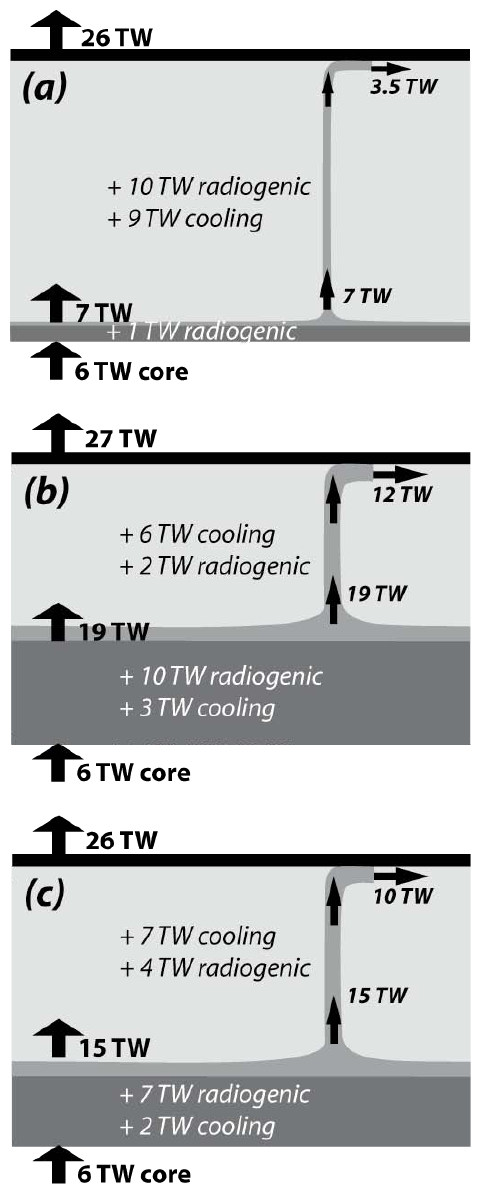
Fig. 23. Heat budgets of alternative mantle models. (a) Preferred model: thin D 00 region and a mildly depleted MORB source com- prising most of the mantle. (b) Deep mantle layer containing about half of the Earth’s refractory incompatible elements. (c) Deep hid- den layer that would ensure chondritic overall composition, as pro- posed by Carlson and Boyet (2008). Only (a) is consistent with observed hotspot swells. See text for